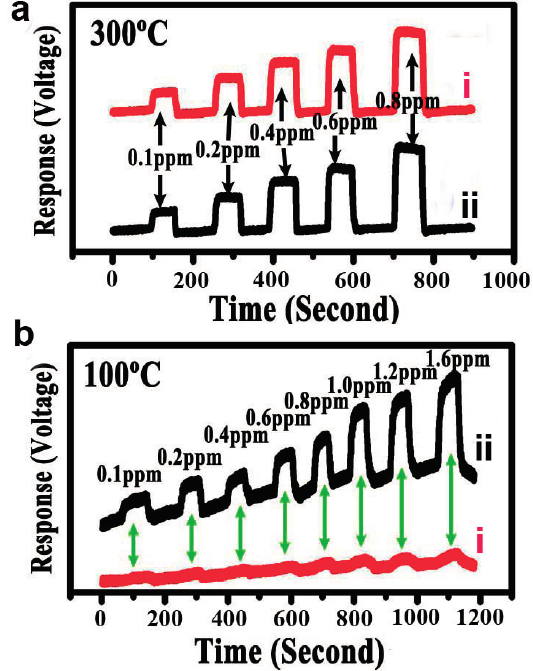
Figure 4. Nitrogen adsorption-desorption isotherms of the as-prepared samples, inset is the corresponding pore size distribution curve: ( a ) Z 1; ( b ) Z 2.